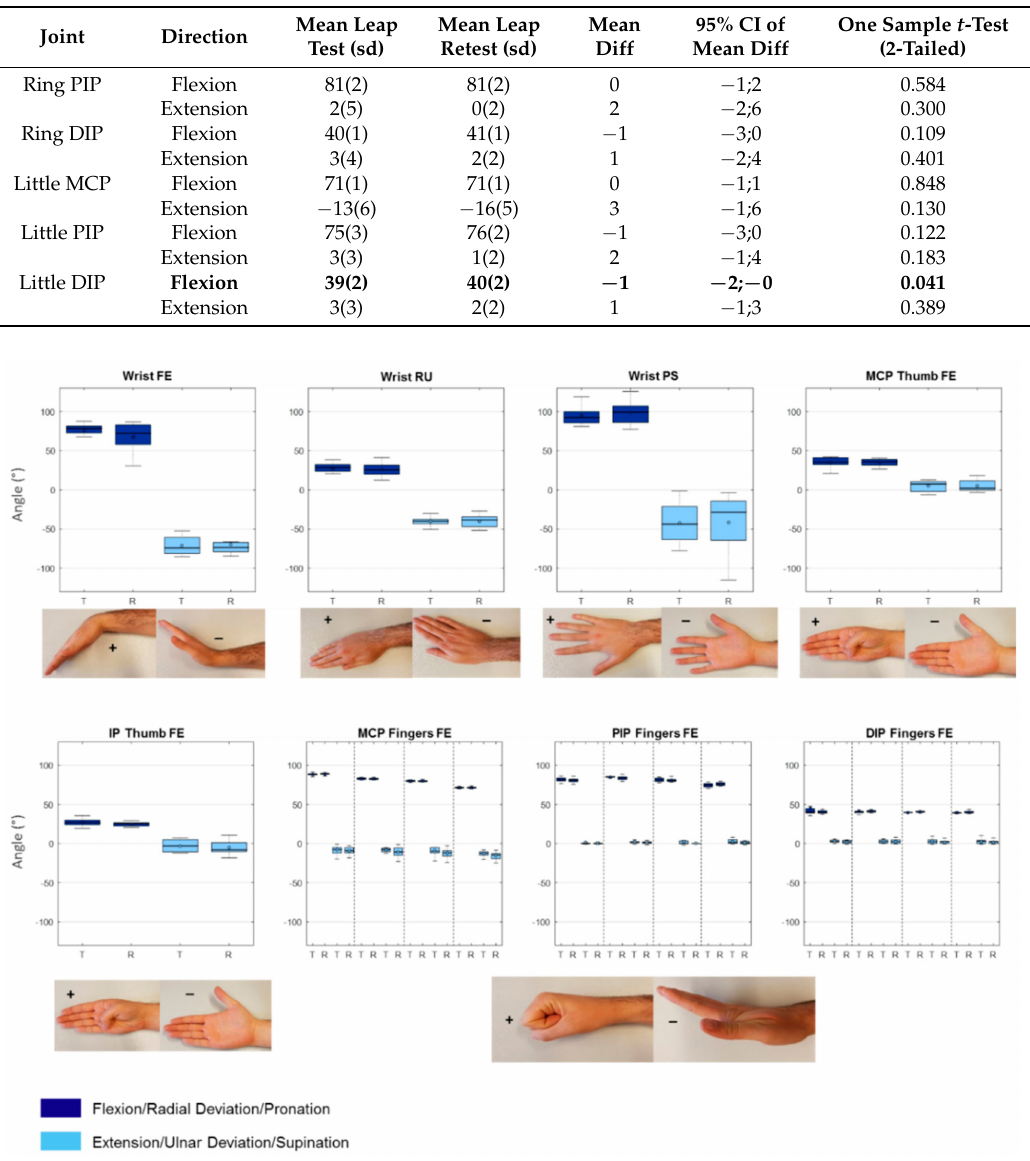
Figure 6. Boxplots of the maximal and minimal values of all the joints measured with the Leap motion sensor test and retest. T: Test data from the Leap motion sensor; R: Retest data from the Leap motion sensor; FE: Flexion/Extension; RU: Radial/Ulnar deviation; PS: Pronation/Supination; for the fingers, the order is index, middle, ring, little, from left to right. For every pair of boxplots, flexion/radial deviation/pronation is left and extension/ulnar deviation and supination